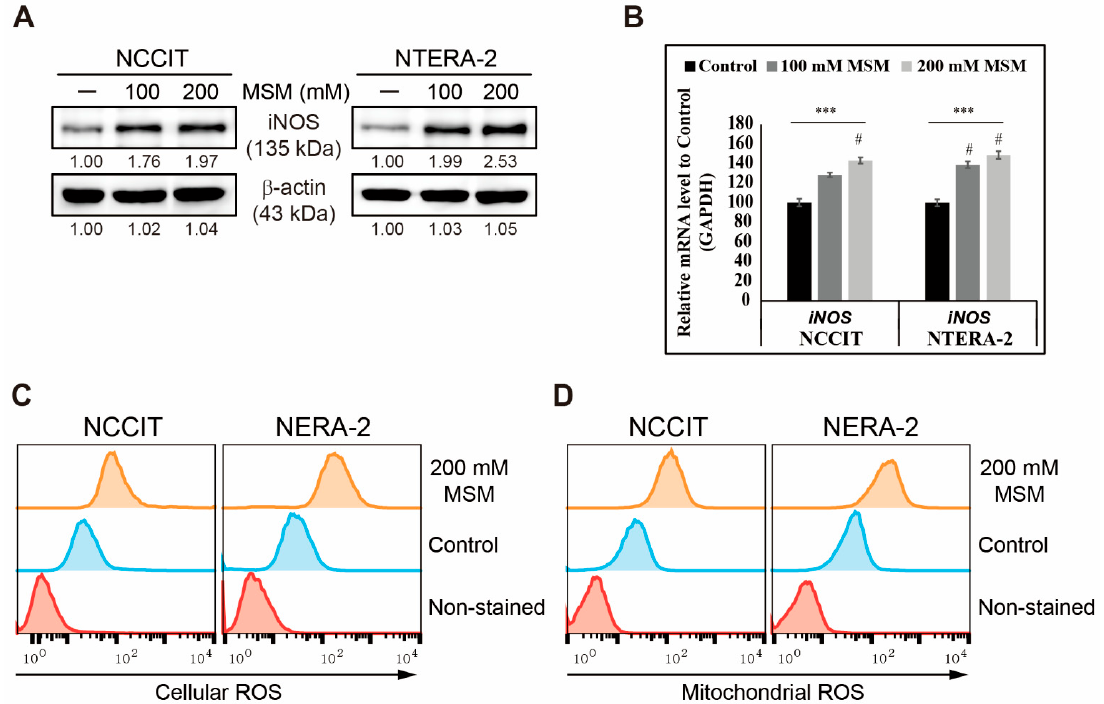
Figure 2. ROS induction in embryonic CSC by MSM. ( A ) Western blotting of NCCIT and NTERA-2 cells with 100 and 200 mM MSM for 48 h shows iNOS protein expression. Expression levels were estimated by densitometry and normalized to β -actin. Data were obtained in triplicate. ( B ) Real-time qPCR analysis showing illustrative expression of the iNOS gene in the NCCIT and NTERA-2 cells. Cp values were normalized to GAPDH mRNA. Controls were set at 100. *** p < 0.001 (ANOVA). # p < 0.001 vs. control. ( C ) Flow cytometry of cellular ROS in NCCIT and NTERA-2 cells after treatment with 200 mM MSM for 48 h. The graphical representation shows cells with ROS induction. ( D ) Flow cytometry of mitochondrial ROS by 200 mM MSM in NCCIT and NTERA-2 cells for 48 h. The graphical representation shows cells with mitochondrial ROS induction.